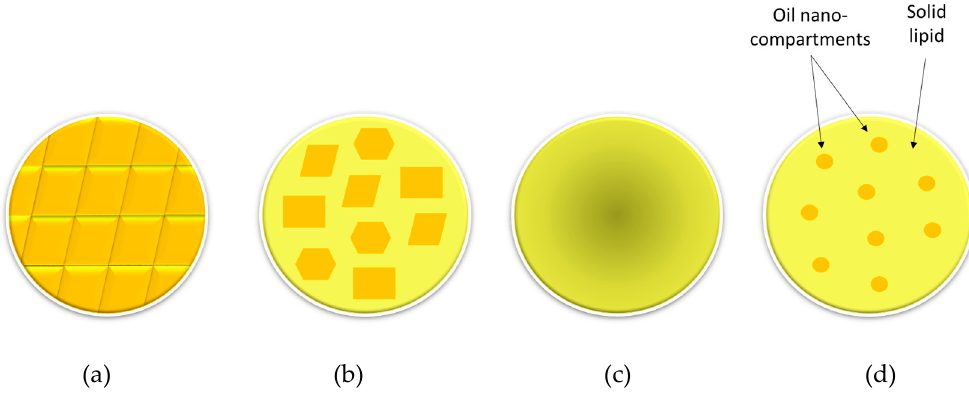
Figure 3. Schematic representation of SLNs and different nanostructured lipid carrier (NLC) types depending on their nanostructures. ( a ) SLN, ( b ) imperfect NLC, ( c ) structureless NLC, and ( d ) multiple oil in solid fat in water O/F/W NLC. Adapted from [18].